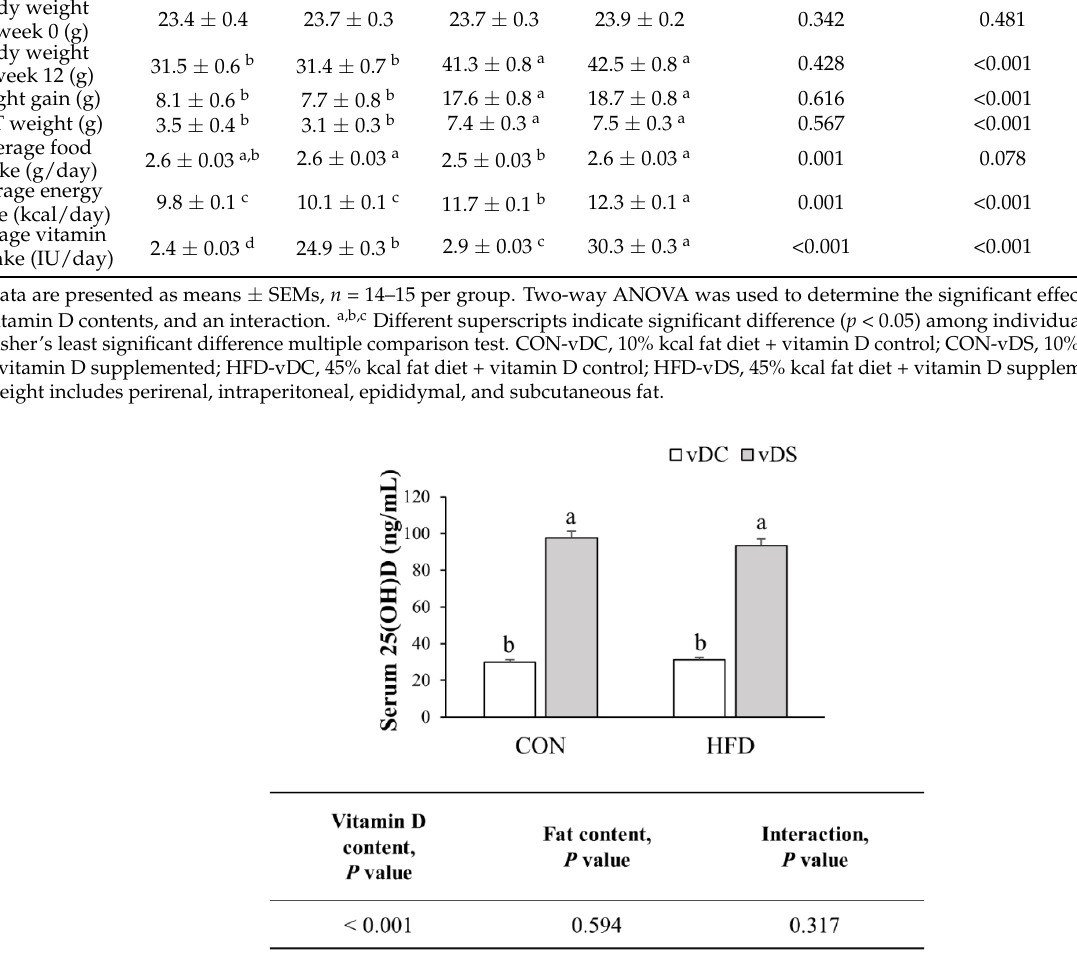
Figure 1. Serum 25(OH)D concentration. Data are presented as means ± SEMs, n = 9 per group. Two-way ANOVA was used to determine the significant effects of fat and vitamin D contents, and an interaction. a,b Different superscripts indicate significant difference ( p < 0.05) among individual groups, by Fisher’s least significant difference multiple comparison test. CON-vDC, 10% kcal fat diet + vitamin D control; CON-vDS, 10% kcal fat diet + vitamin D supplemented; HFD-vDC, 45% kcal fat diet + vitamin D control; HFD-vDS, 45% kcal fat diet + vitamin D